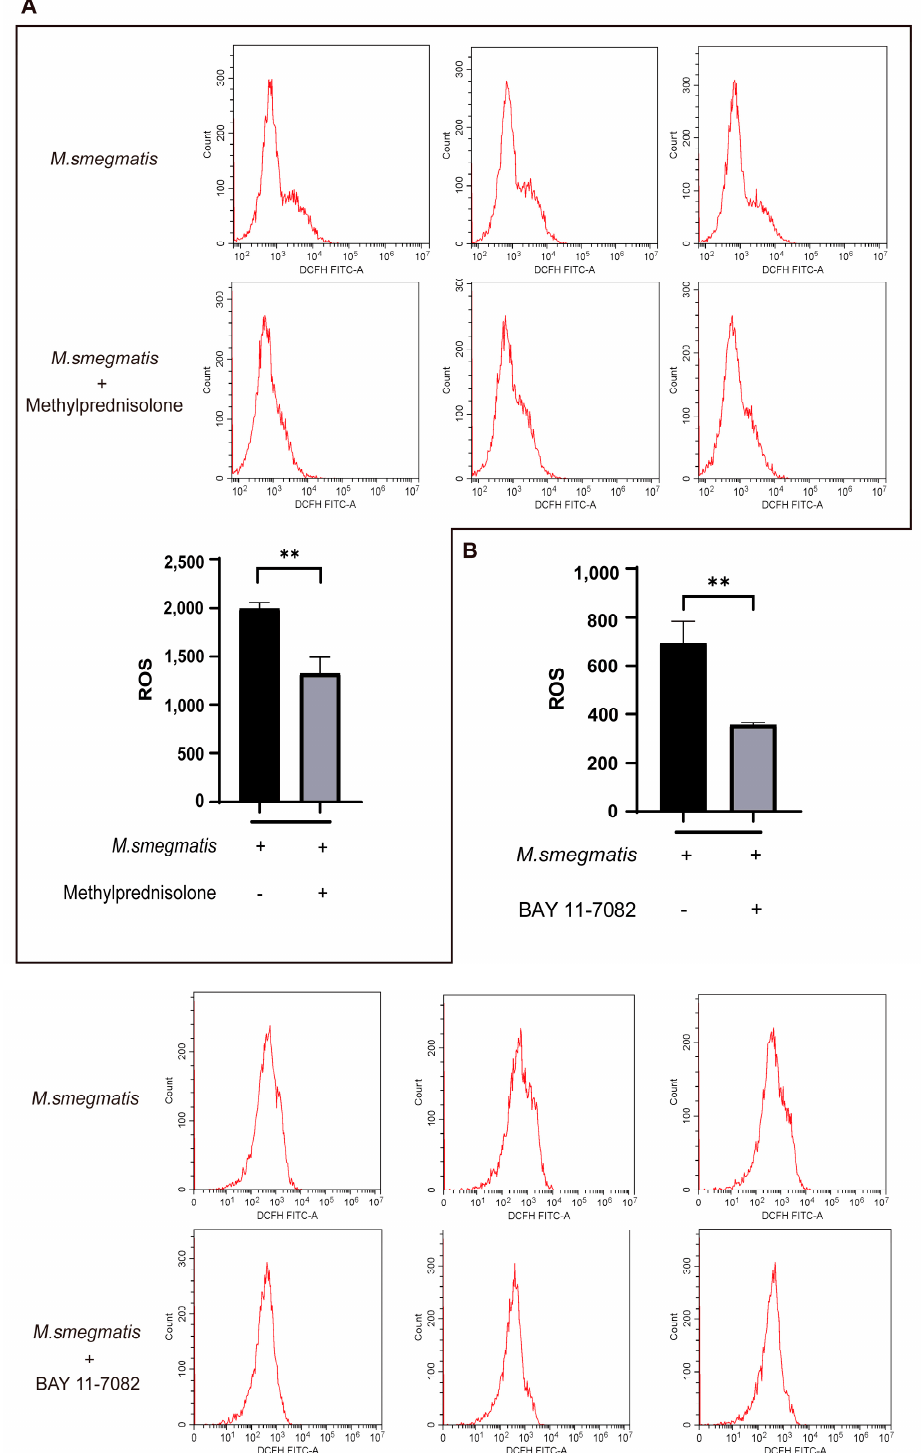
Figure 4. ( A ) Methylprednisolone (10 2 µ M) treated M. smegmatis infected RAW264.7 cells for 48 h; flow cytometry was used to detect the level of cellular ROS production; the t-test was used for data analysis; ** p < 0.01. ( B ) BAY 11-7082 (2 µ M) treated M. smegmatis infected RAW264.7 cells for 48 h; flow cytometry was used to detect the level of cellular ROS production; the t-test was used for data analysis; ** p < 0.01.